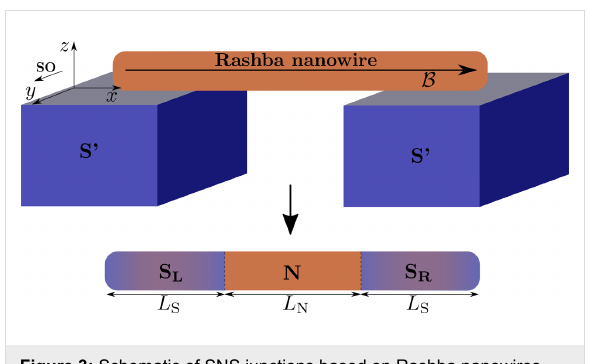
Figure 3: Schematic of SNS junctions based on Rashba nanowires. Top: A nanowire with Rashba SOC of length L = L S + L N + L S placed on top of two s -wave superconductors (S’) with pairing potentials Δ S ′ and subjected to an external magnetic field (denoted by the black arrow). Superconducting correlations are induced into the nanowire through the proximity effect. Bottom: Left and right regions of the nano- wire become superconducting, denoted by S L and S R , with induced pairing potentials and chemical potentials , while the central region remains in the normal state with Δ N = 0 and chemi- cal potential μ N . This results in a superconductor–normal–supercon- ductor (SNS)